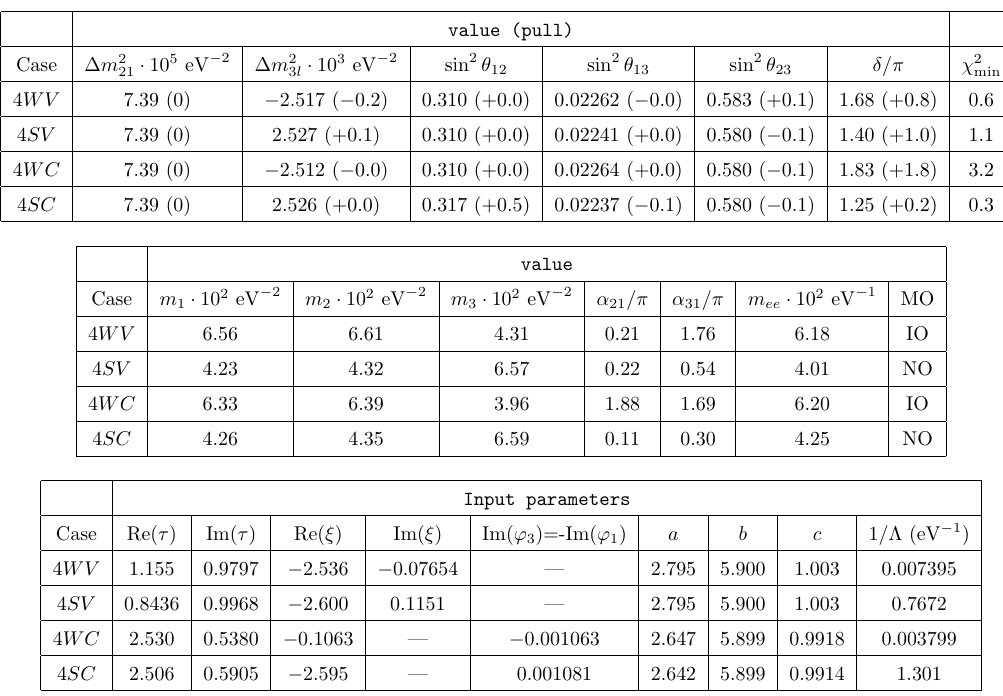
Table 7 . Results of the (cid:12)t to lepton data for the (cid:0) 4 models. In the top panel, best values and pulls for the observables used in the (cid:12)t. Also the minimum (cid:31) 2 is shown. In the middle table, predictions of the models: neutrino masses, phases and parameter m ee relevant for neutrinoless double beta decay. In the bottom panel input parameters at the minimum of the (cid:31) 2 function. We have (cid:12)xed ’ 2 = 0 : 01 for all four cases. To simplify the notation, the factors cos ^ (cid:12) and 1 = sin 2 ^ (cid:12) have been omitted from a , b , c and (cid:3),